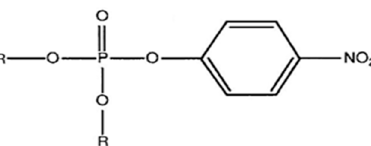
Figure 1. Comparative structure of two derivatives from paraoxon. R = -CH 3 for dimethyl paraoxon (DMPO) and R = -CH 2 -CH 3 for diethyl paraoxon (DEPO).